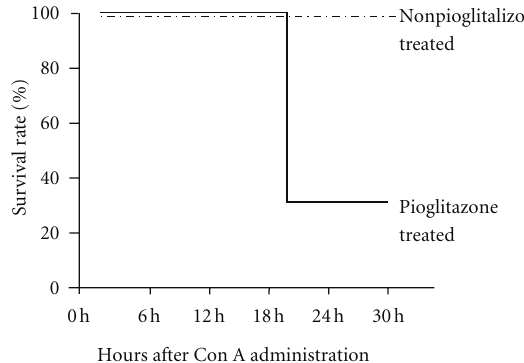
Figure 2: At 20 h after Con A injection, there were no cases of fatality in the nonpioglitazone-treated group of mice, whereas the fatality rate was 70% in the pioglitazone-treated